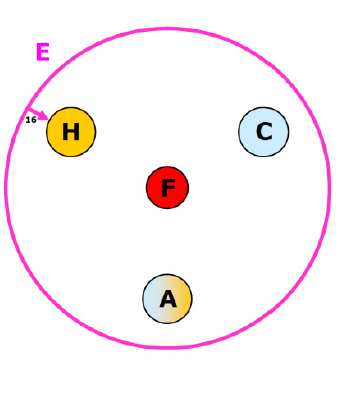
Fig. 9. – Electric heating.